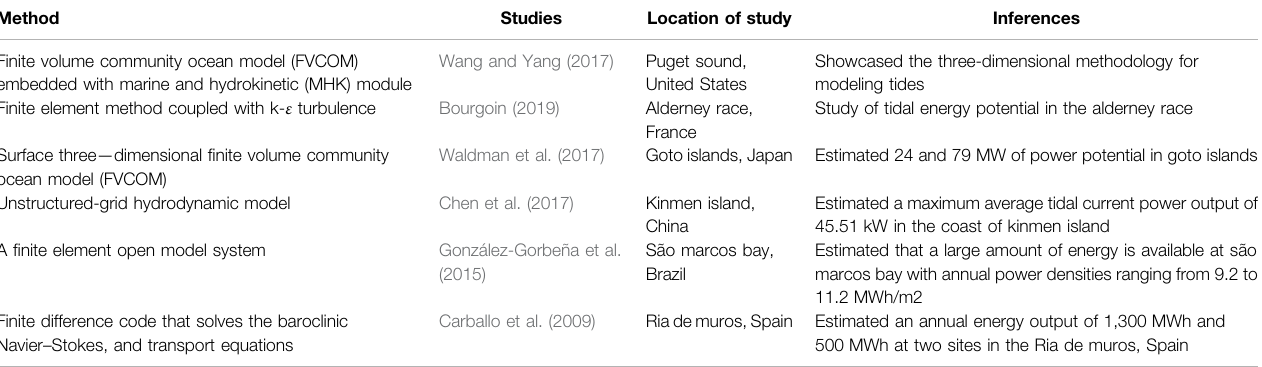
TABLE 1 | Some of the key tidal resource modeling